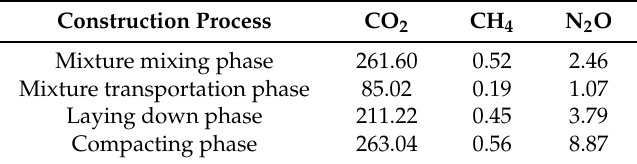
Table 5. The GHG emissions from fuming asphalt mixture (units: kg).